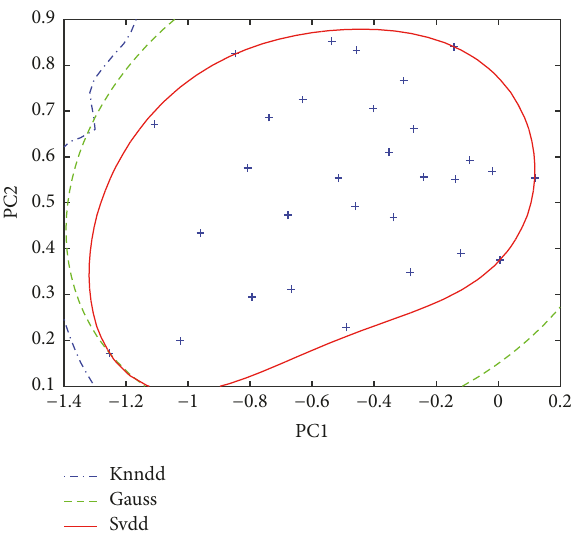
Figure 4: Application of the data description models of class B on the test